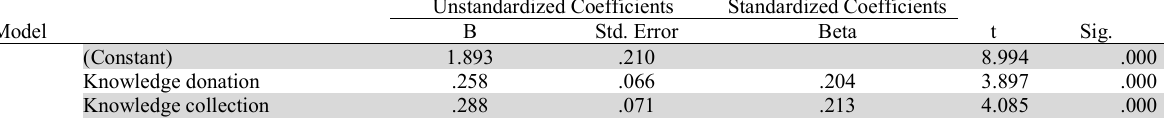
Regression results for the impact of knowledge donation, knowledge collection on innovative work behavior